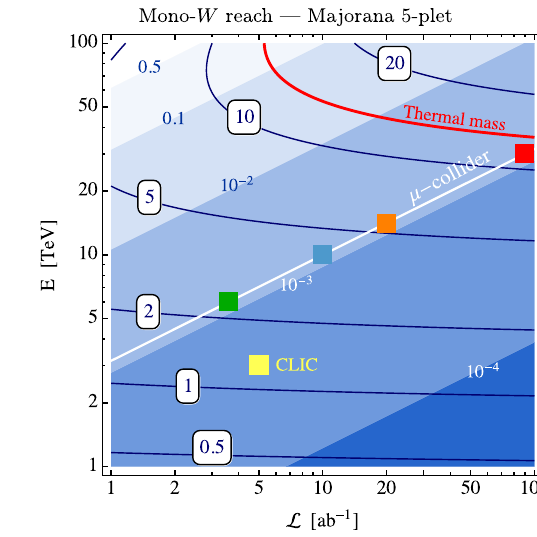
tainties are assumed to be negligible. The white line corresponds to the luminosity scaling Eq. (24), with various collider benchmarks shown as √ √ √ s = 6 TeV green, s = 10 TeV blue, s = 14 TeV colored squares: √ s = 30 TeV red. The yellow square corresponds to the 3 orange and TeV CLIC [58]. Left: Majorana 3-plet. Right: Majorana